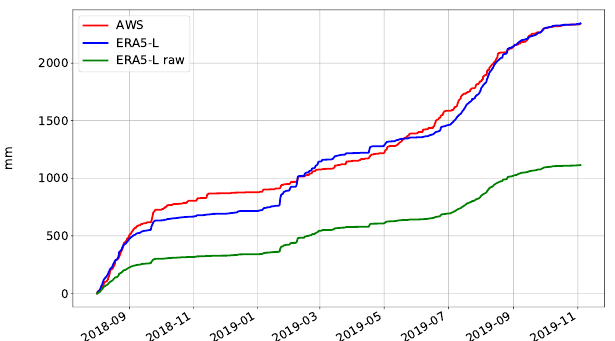
Figure 4. Cumulative measured (AWS), unscaled (ERA5-L-raw) and scaled (ERA5-L) hourly total precipitation from 2 August 2018 to 2 November